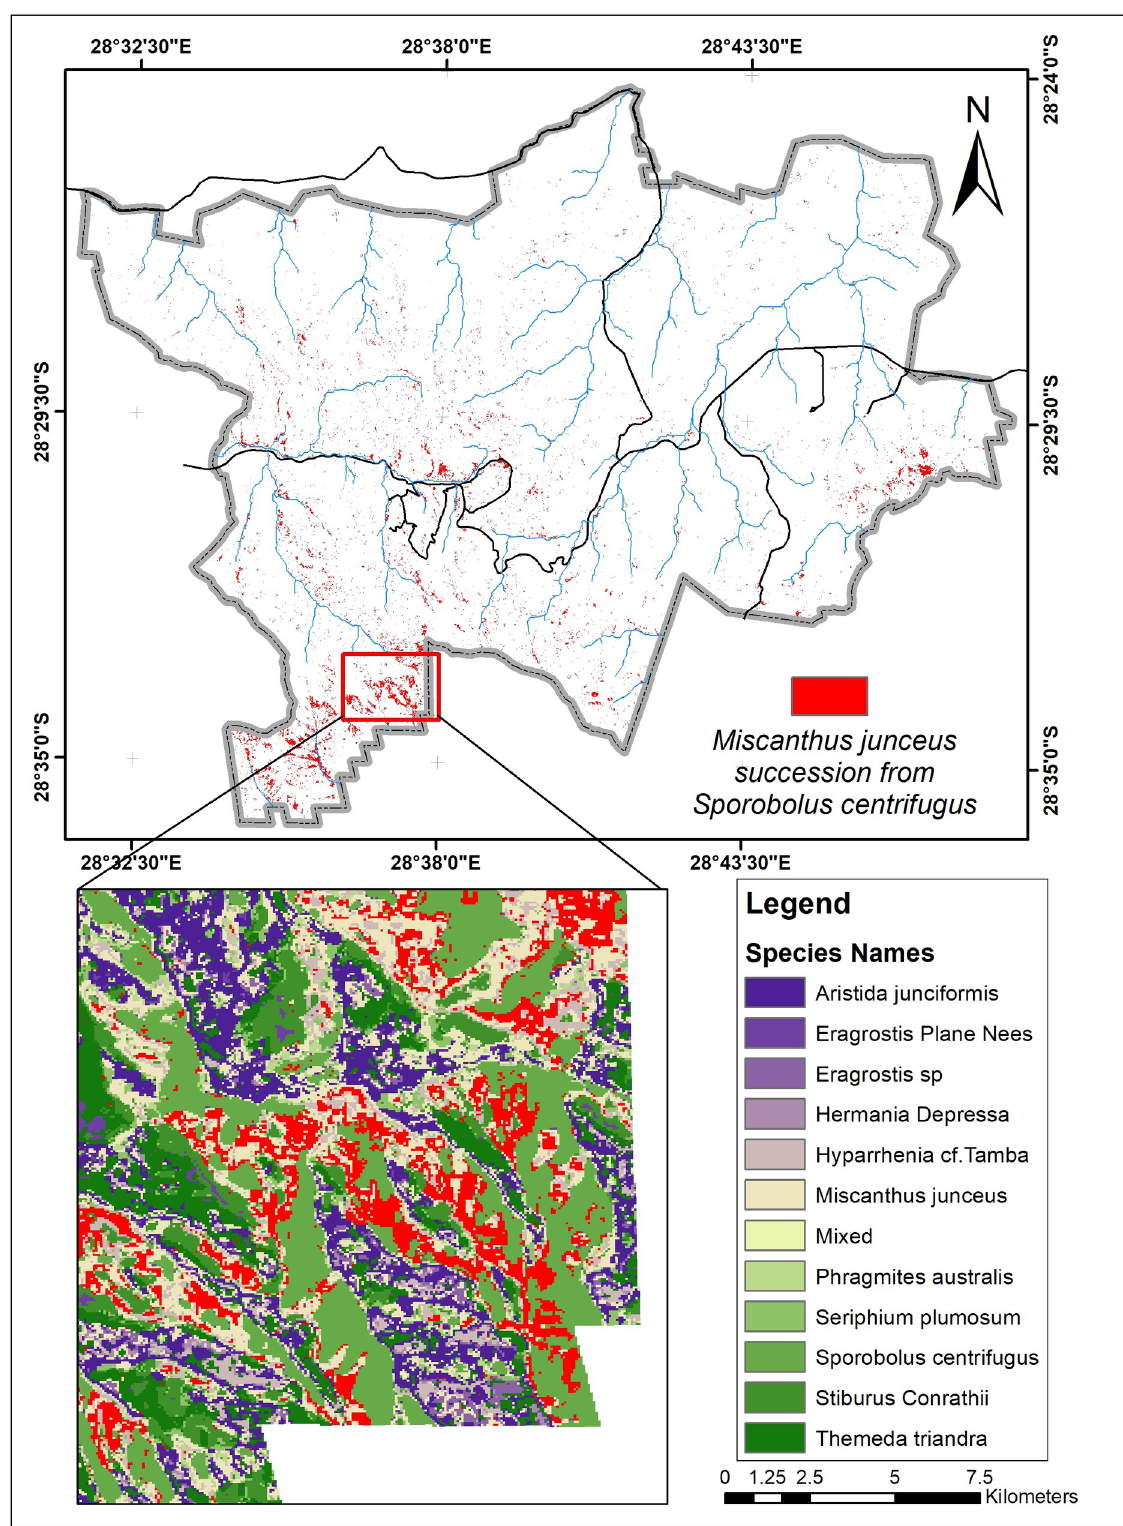
Fig 8. Areas where M . junceus succeeded from S . centrifugus